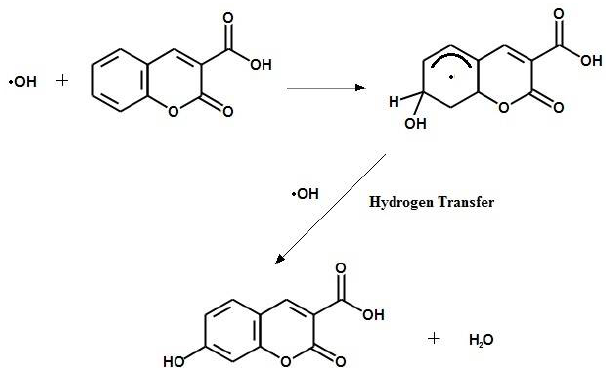
Figure 1. Hydroxyl radicals react with C3CA to yield umbelliferone through hydrogen abstraction, transfer, and substitution.